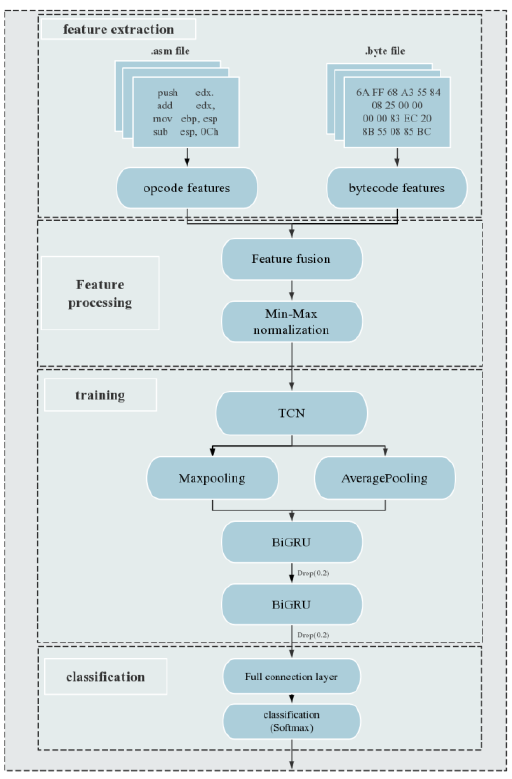
Figure 5. Malware detection model structure.